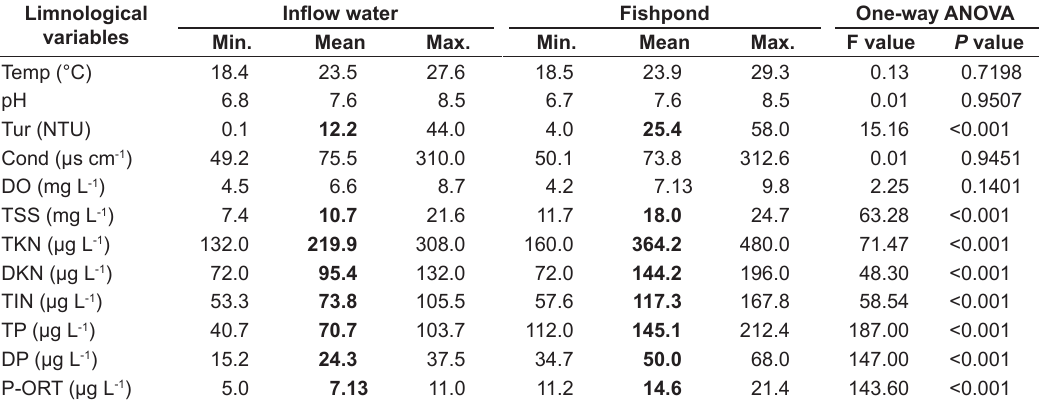
Table 1. Minimum (min.), mean, and maximum (max.) values of the water temperature (Temp), pH, turbidity (Tur), electrical conductivity (Cond), dissolved oxygen (DO), total suspended solids (TSS), total Kjeldahl nitrogen (TKN), dissolved Kjeldahl nitrogen (DKN), total inorganic nitrogen (TIN), total phosphorus (TP), dissolved phosphorus (DP) and orthophosphate-P (P-ORT), in the inflow water and the fishpond of a Nile tilapia production system during grow-out period (n =